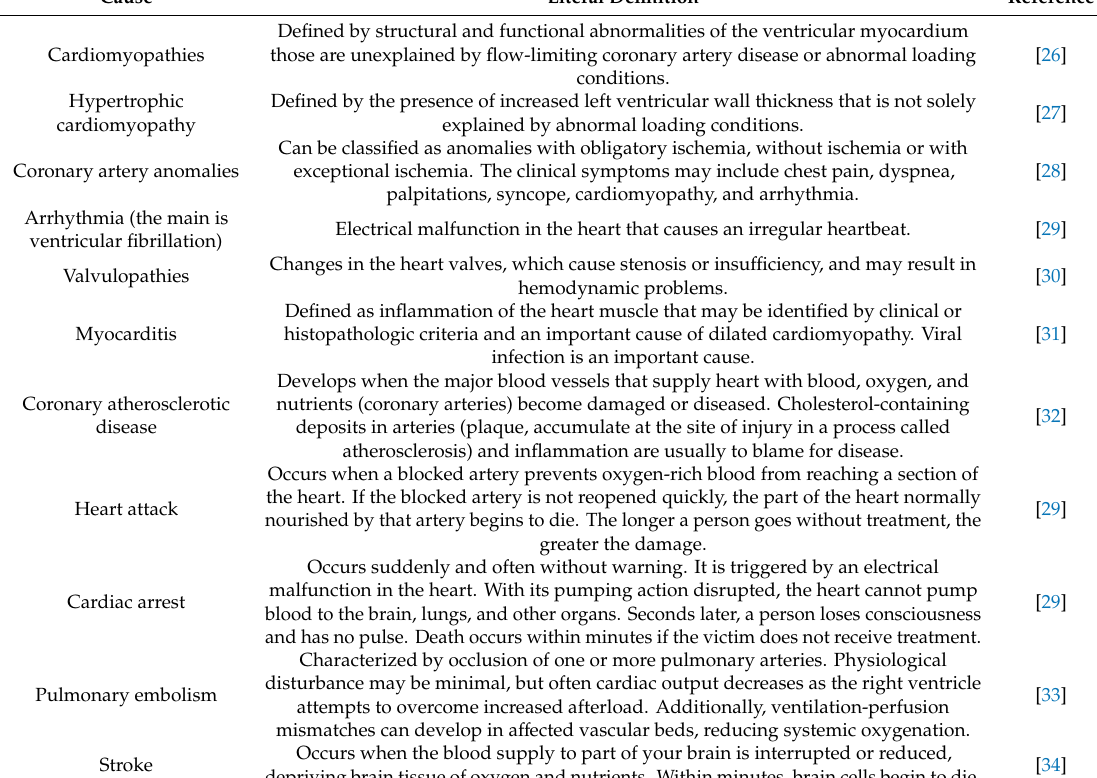
Table 2. Main disturbances and disorders associated with the sudden death of athletes and general population. Cause Literal Definition